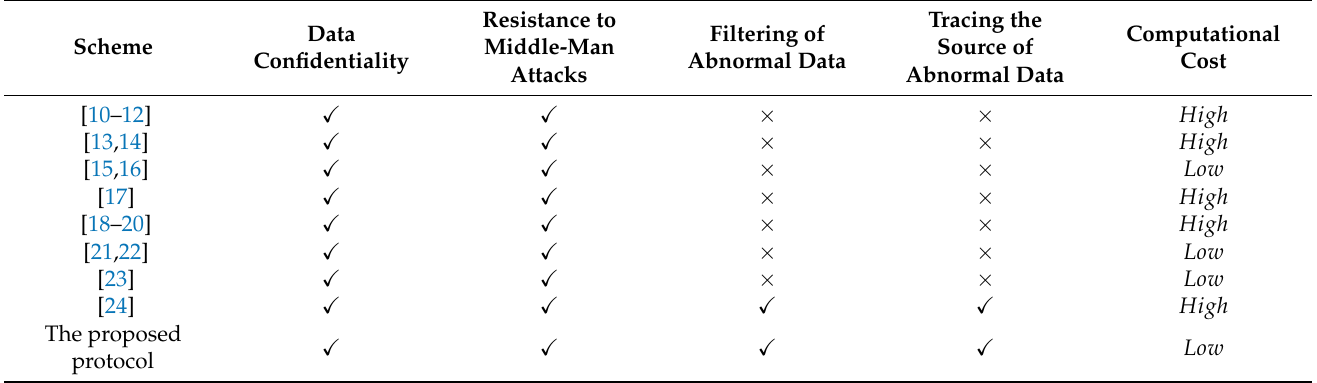
Table 1. Security feature